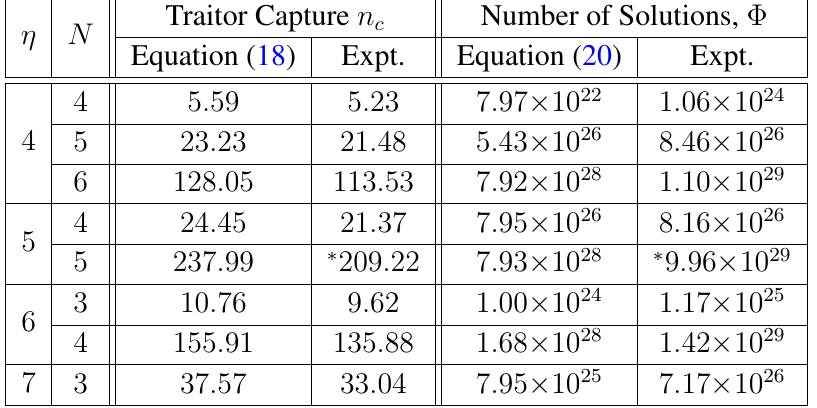
Table 5. Comparison: analytical and experimental results for 1000 runs using p = 31